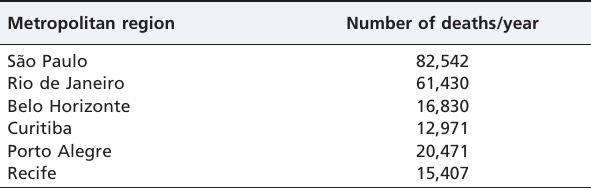
Table 3 - Total number of deaths per year (2007) in the six studied Brazilian metropolitan